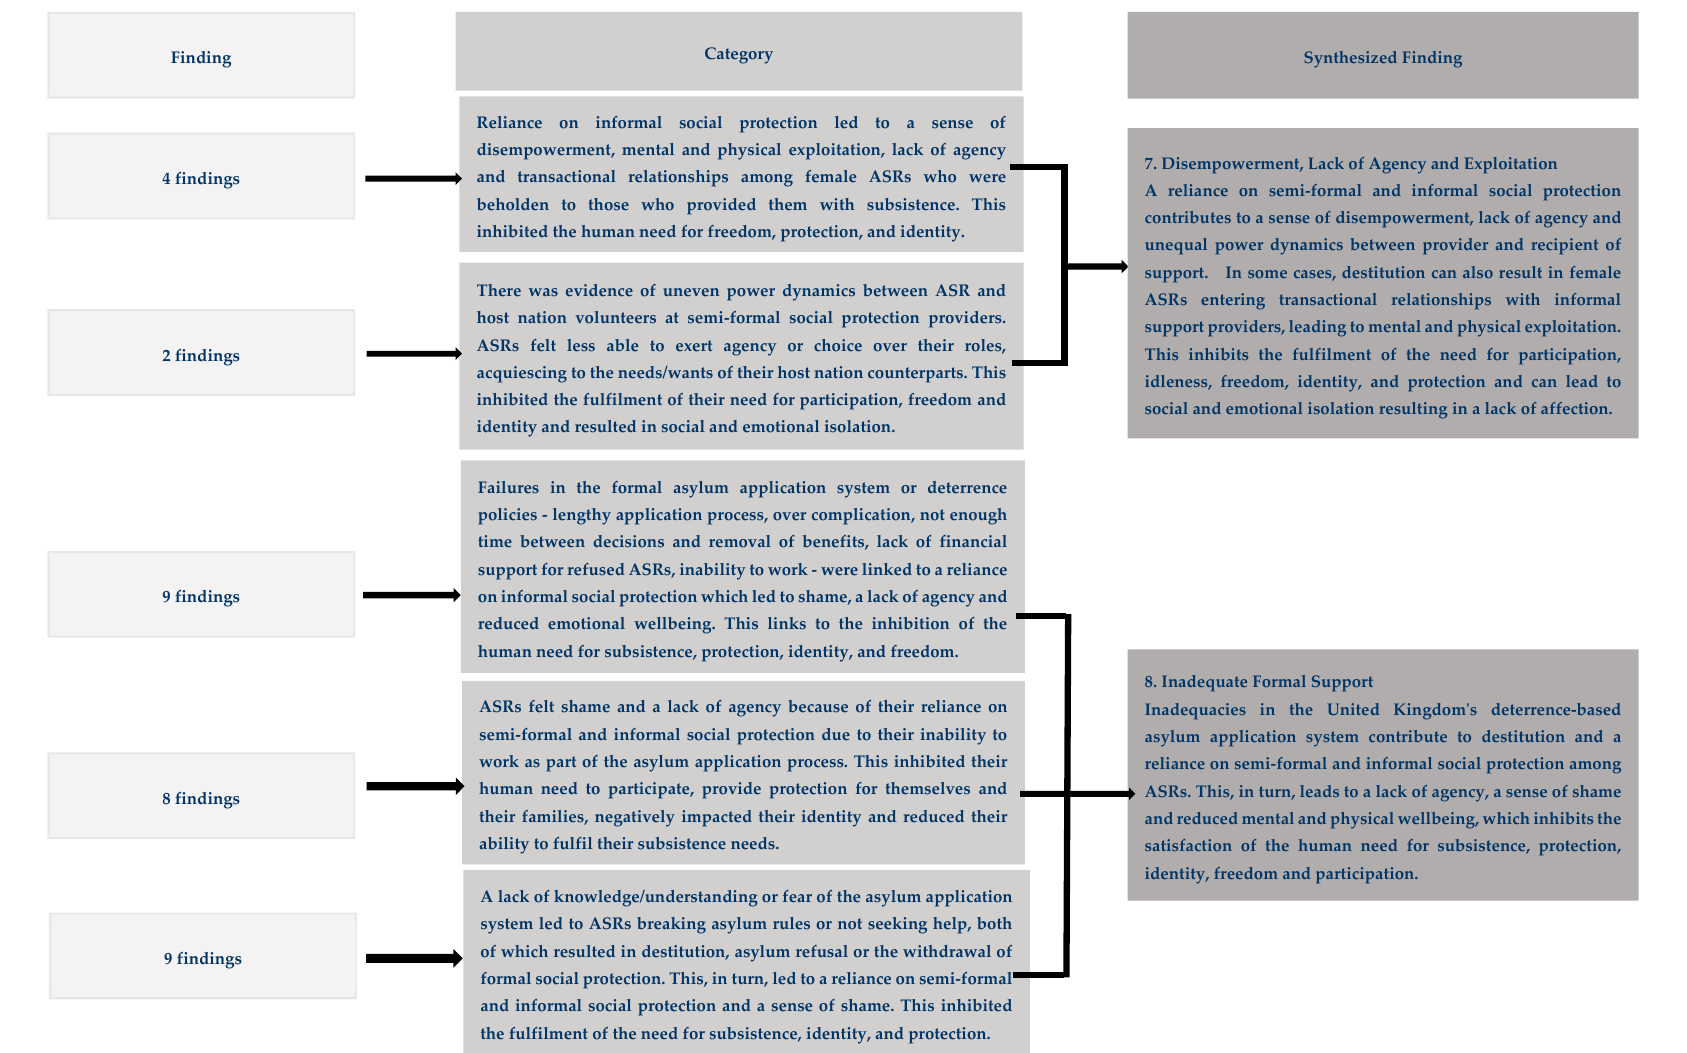
Figure 2. Meta-Aggregation-Synthesized Findings